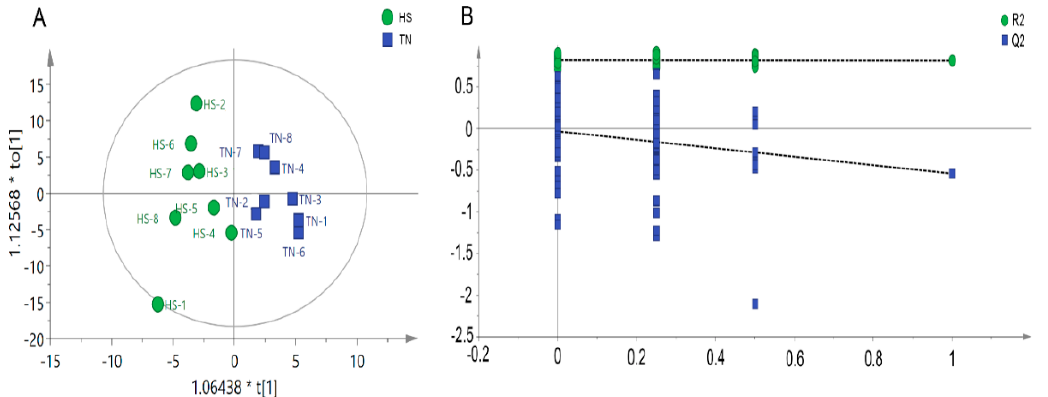
Figure 3. Score plot of orthogonal projections to latent structures discriminant analyses (OPLS-DA) derived from the GC-MS profiles of serum samples obtained from the heat stress (HS) group vs. thermal neutral (TN) group ( A ); Validation plots of the partial least squares discriminant analysis (OPLS-DA) models acquired through 999 permutation tests for the GC-MS data of serum metabolome ( B ).